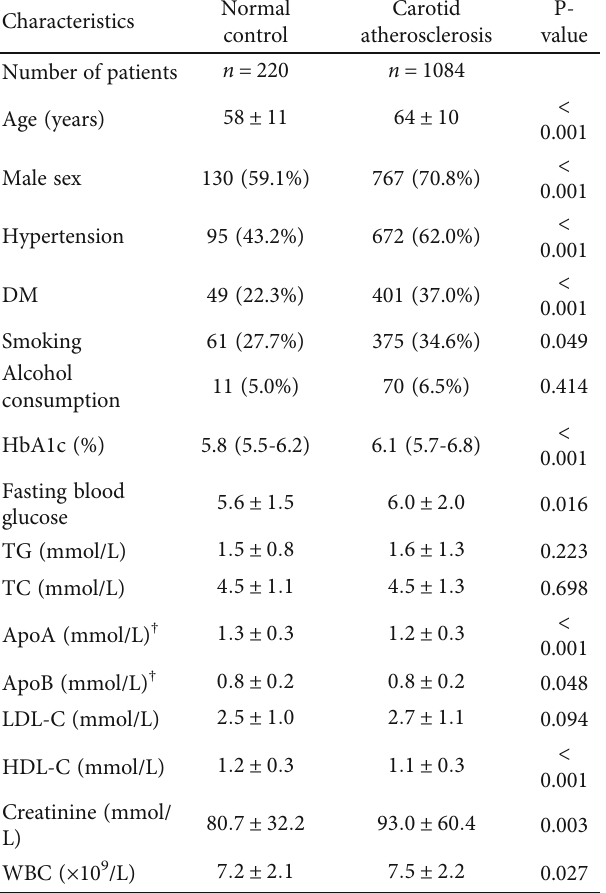
Table 1: Baseline information according to quartiles of the HbA1c/HDL-C